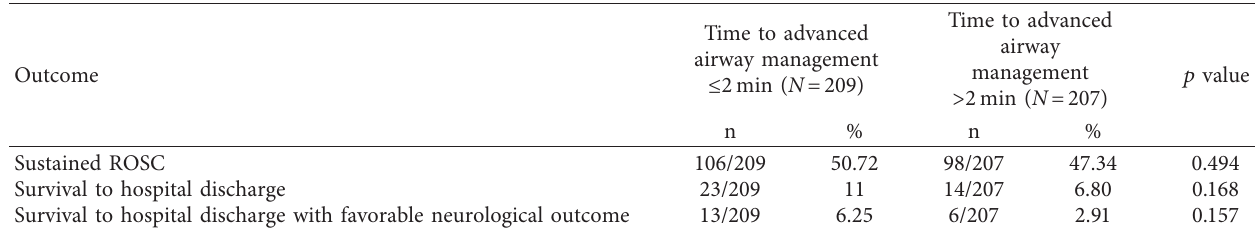
Table 2: Outcome of resuscitation between time to advanced airway management ≤ 2 minutes and > 2 minutes.